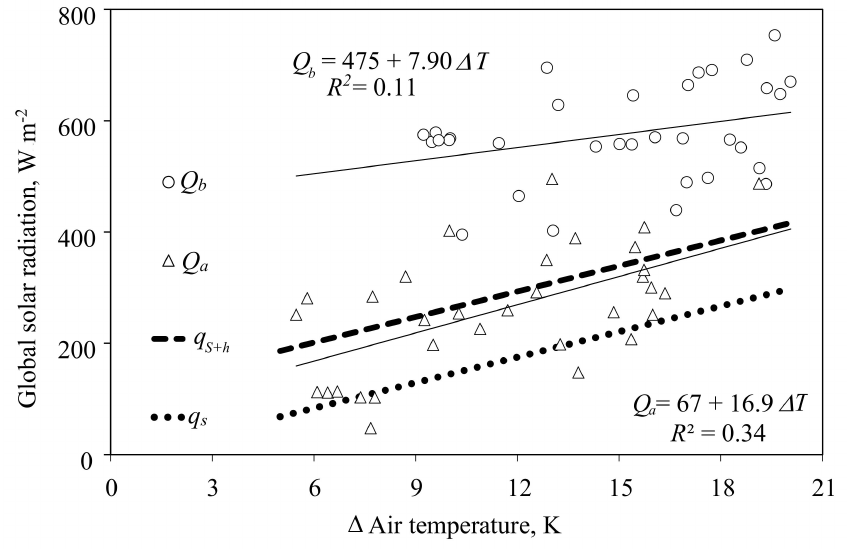
Figure 4. Constraints of outside global radiation and air temperature for the gas exchange measurement of an adult tomato crop in the period from 22 March to 16 May 2016 at supply air rates of 200 m 3 h − 1 . A total of 33 data points depict the hourly average of the outside global radiation (W m − 2 ) as a function of the di ff erence of the air temperature in the cabin and outside the greenhouse ( ∆ T , K) during the hour before ( Q b ) or after ( Q a ), when the roof vents opened for the first or last time of the day, respectively. On the remaining 23 days, the vents did not open at any time. Solid lines represent regression lines and dotted lines represent the calculated constraints of the global radiation according to the sensitive heat transfer, q s (W m − 2 ), and sensitive plus latent heat transfer q s + l (W m − 2 ) out of the cabin. Transpiration of 120 g m − 2 h − 1 related to a cultivation area of 24 m 2 and a transmission coe ffi cient of 0.6 of the cabin cover for global radiation were